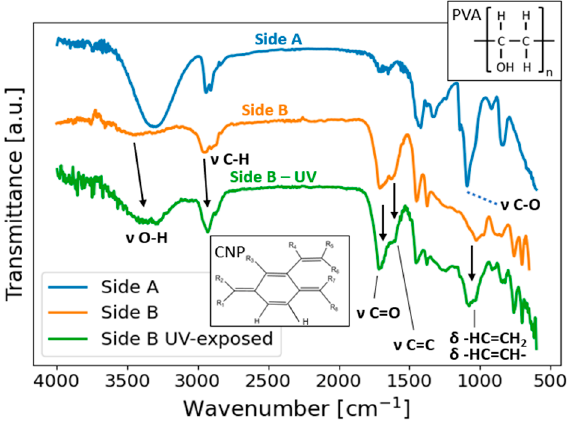
Figure 5. FTIR spectra of the Janus membrane: Side A (blue), Side B (orange), and Side B after UV exposure (green). The inset shows the predominant chemical composition for each case.